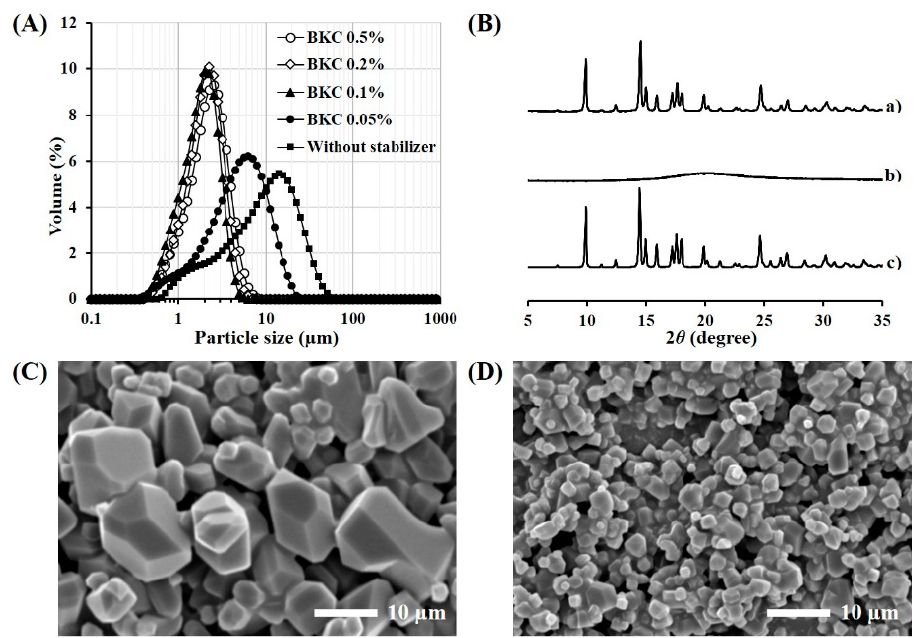
Figure 1. Morphological and physical characteristics of TA microcrystals. ( A ) Size distribution of the drug microcrystals stabilized by BKC, ( B ) XRD patterns of (a) TA raw material, (b) BKC powder, and (c) TA microcrystals, SEM images of ( C ) TA raw material, and ( D ) TA microcrystals stabilized by BKC at the concentration of 0.1 w/v %.